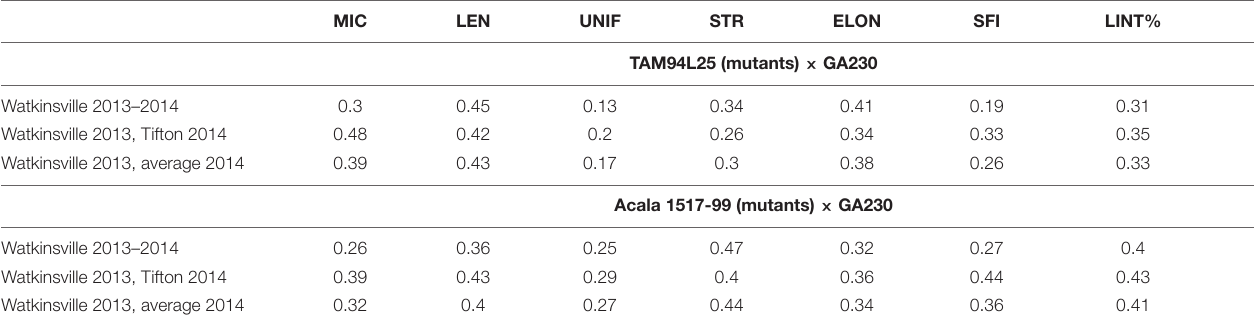
TABLE 3 | Narrow-sense heritability (h2) between F2 and F2:3 value for MIC, LEN, UNIF, STR, ELON, SFC, and LINT% in TAM 94L25 (mutants) × GA230 and Acala 1517-99 (mutants) × GA230 background. MIC LEN UNIF STR ELON